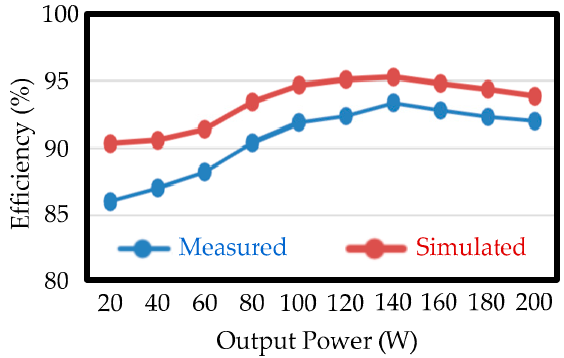
Figure 7. The measured and simulated efficiencies of the proposed NIC.